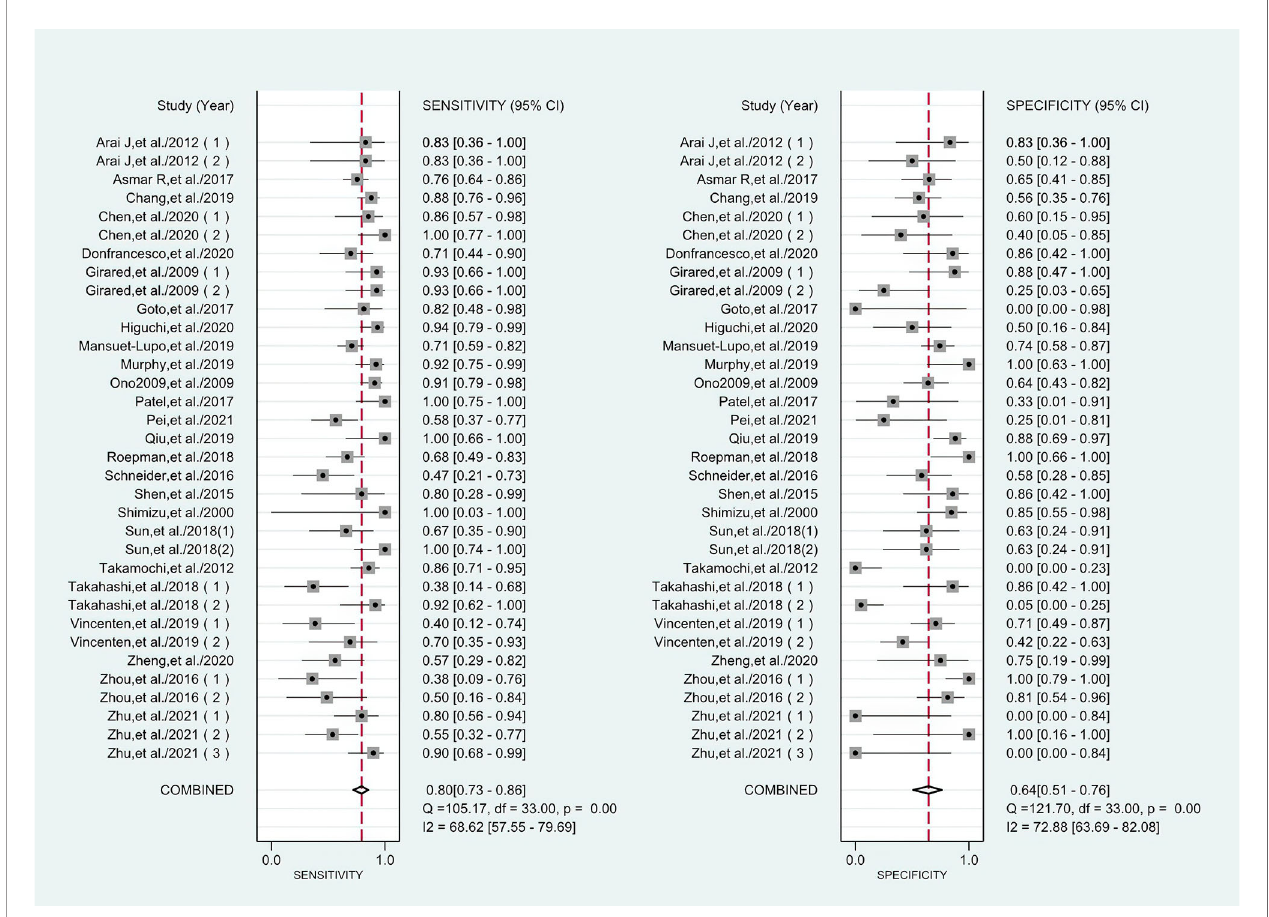
FIGURE 3 | Forest plots of sensitivities and speci fi cities for histology in the differential diagnosis of multiple primary lung cancer (MPLC) and intrapulmonary metastasis